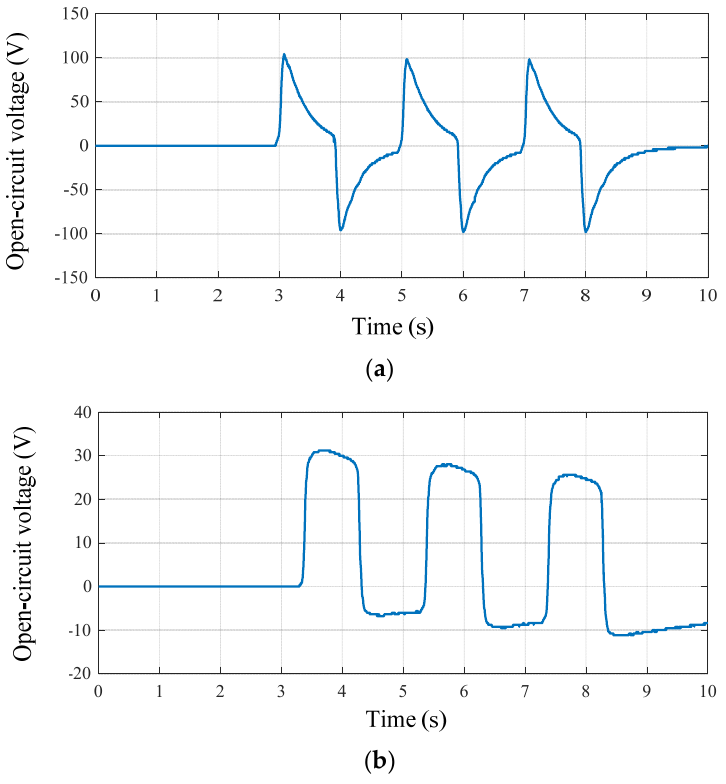
Figure 13. Open-circuit voltages of piezoelectric elements in series and in parallel: ( a ) in series; ( b ) in parallel.